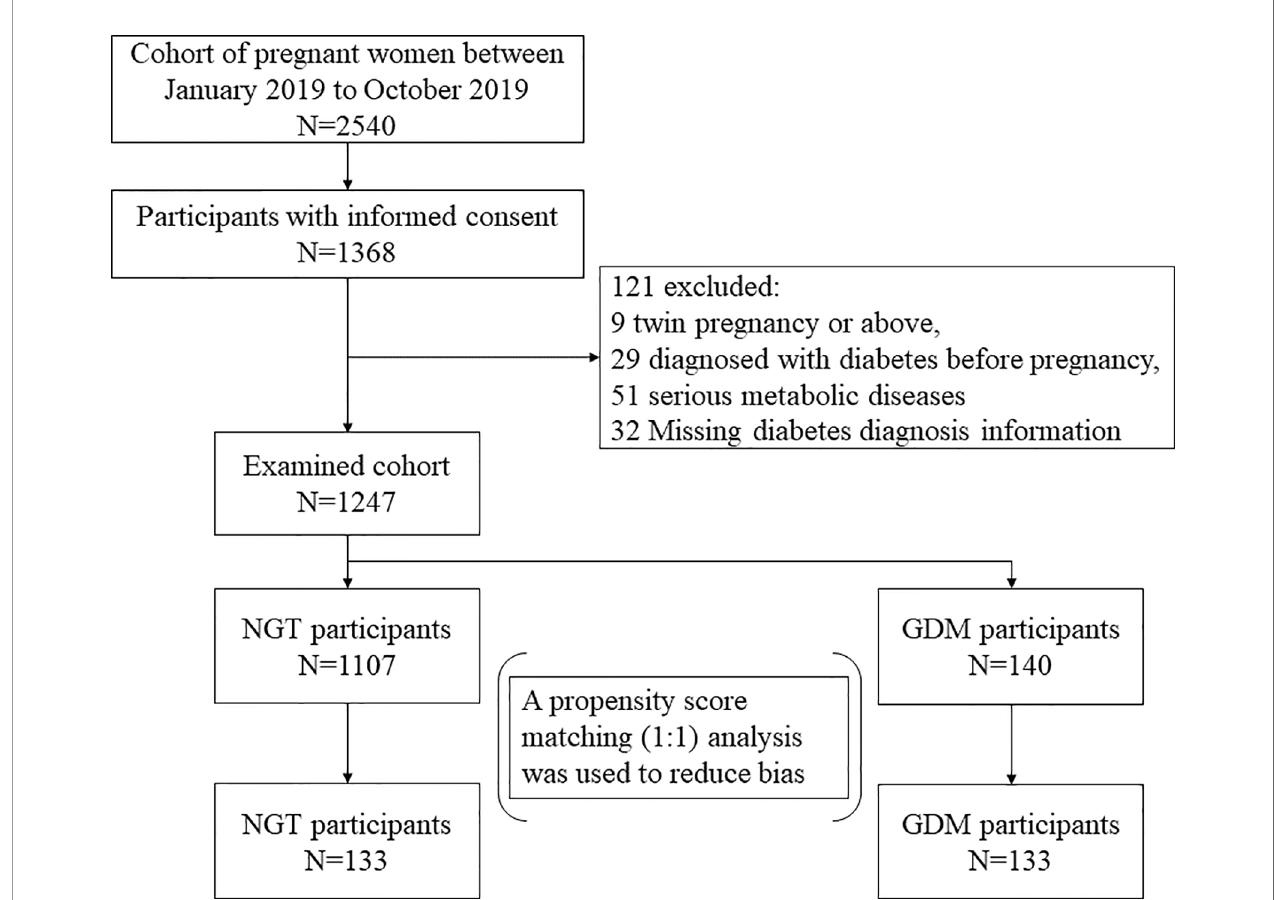
FIGURE 1 | The fl owchart of the selection of the analyzed GDM population and the matched control